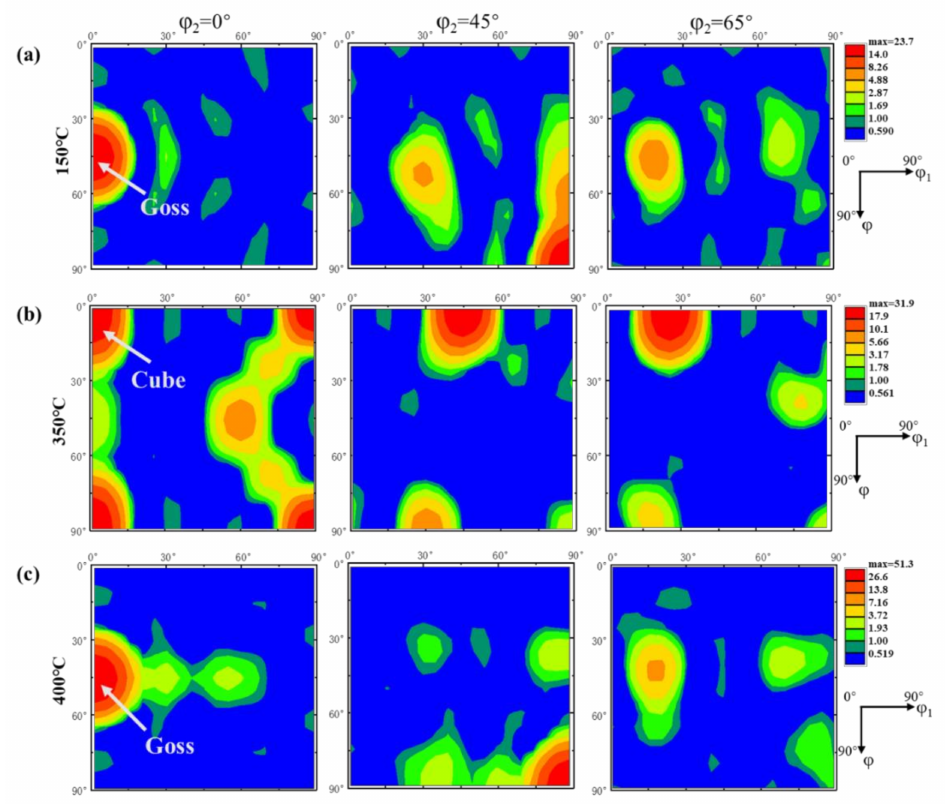
Figure 9. The ϕ 2 = 0 ◦ , 45 ◦ and 65 ◦ ODF sections of the samples annealed at ( a ) 150 ◦ C ( b ) 350 ◦ C and ( c ) 400 ◦ C after Materials 2021 , 14 , x FOR PEER REVIEW thermal cycling (N = 12).